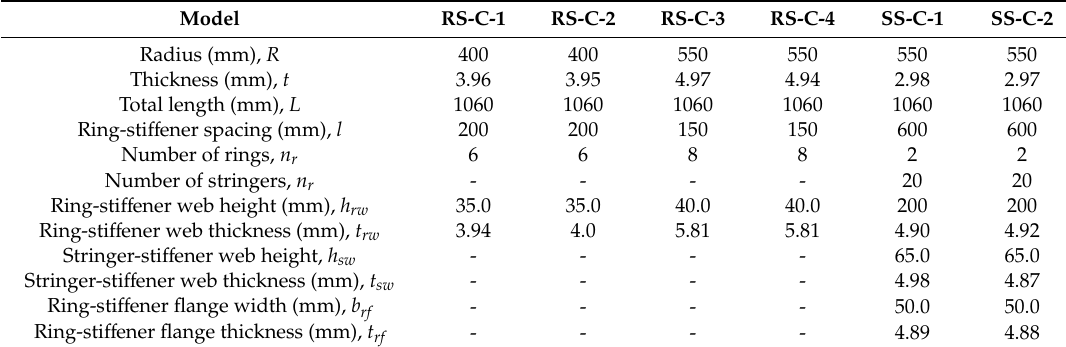
Table 1. Measured dimensions of test models.